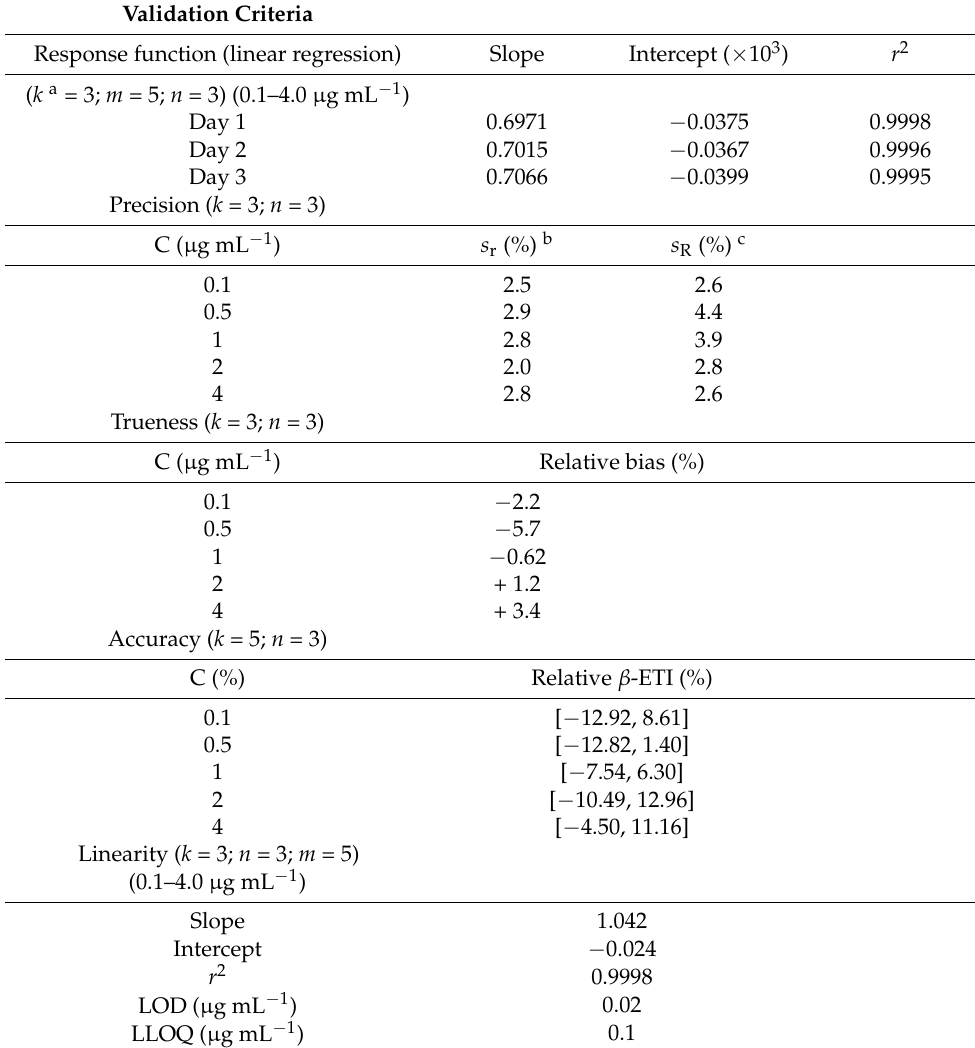
Table 3. Validation results for the determination of PIR in urine. Validation Criteria Response function (linear